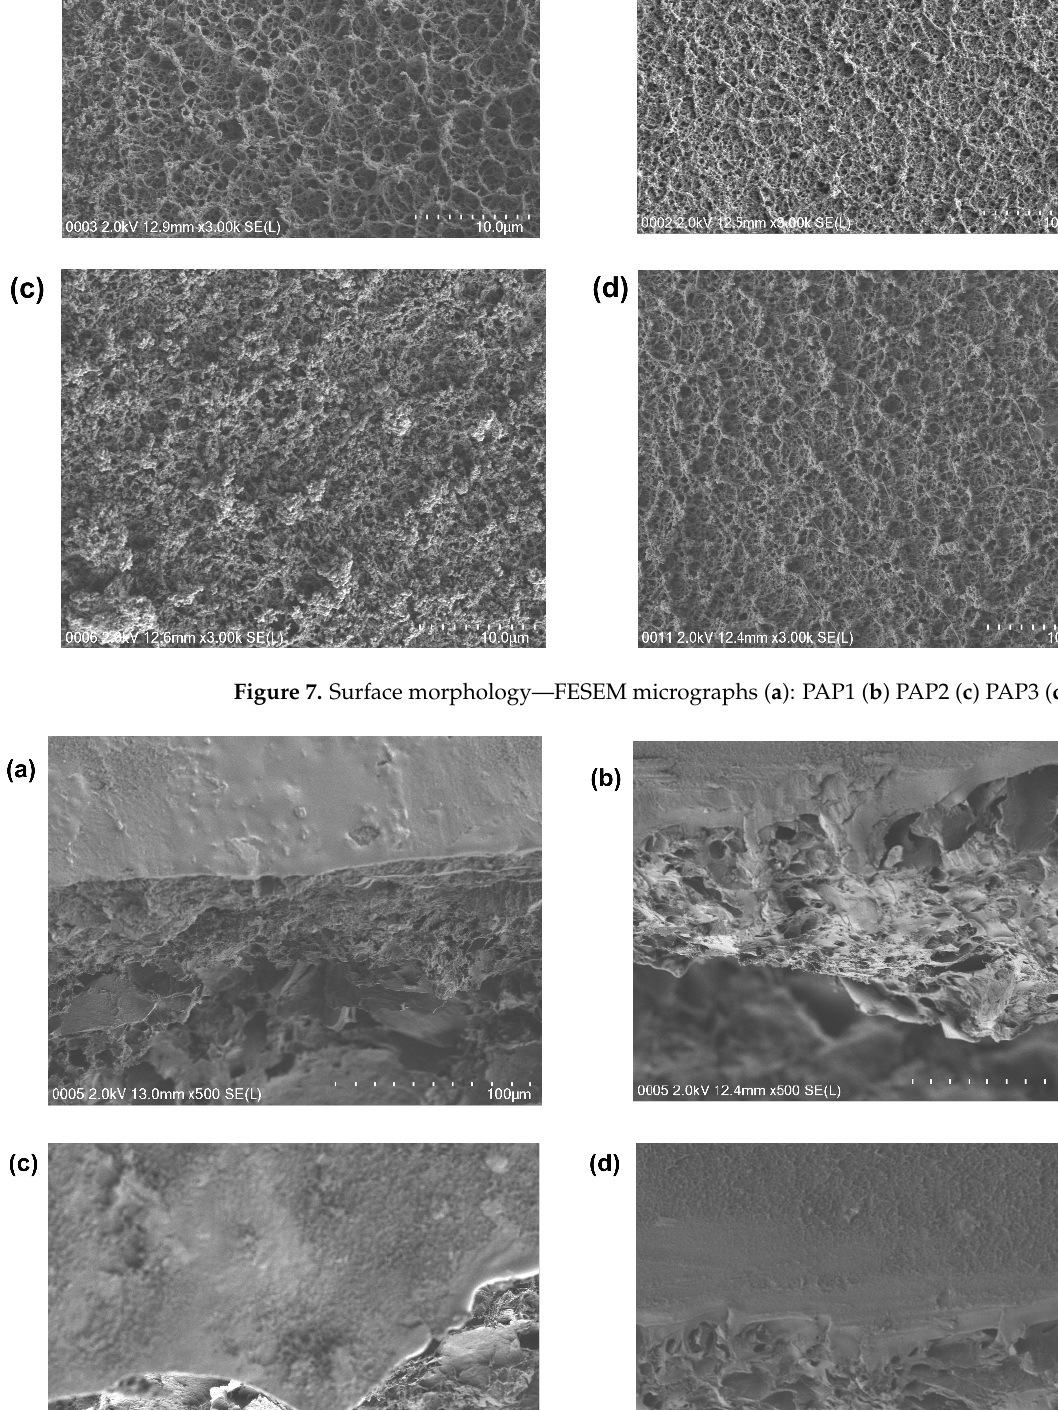
Figure 8. Cross section images of ( a ) PAP1 ( b ) PAP2 ( c ) PAP3 ( d ) PAP4.